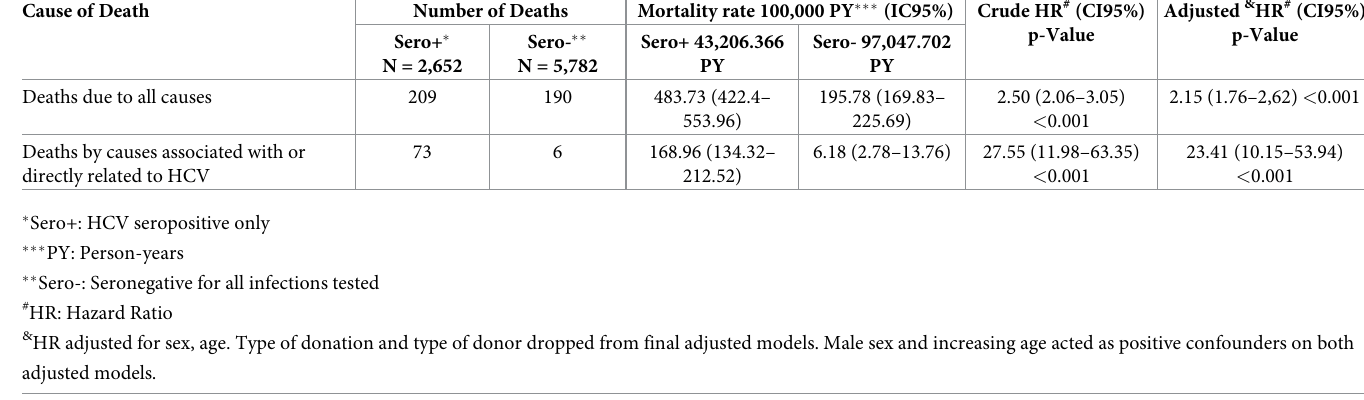
Table 2, which refers to the first analysis mentioned in the topic "Mortality Outcomes", shows that, between 1994 and 2016, when all causes of death were considered, there were 399 deaths between the two groups, 209 of which were in HCV+ individuals and 190 were in HCV- individuals. Thus, the crude hazard ratio (HR) was 2.5 (95%CI: 2.06–3.05; p < 0.001), Table 2. Deaths organized by cause of death and by HCV serological status. Cause of